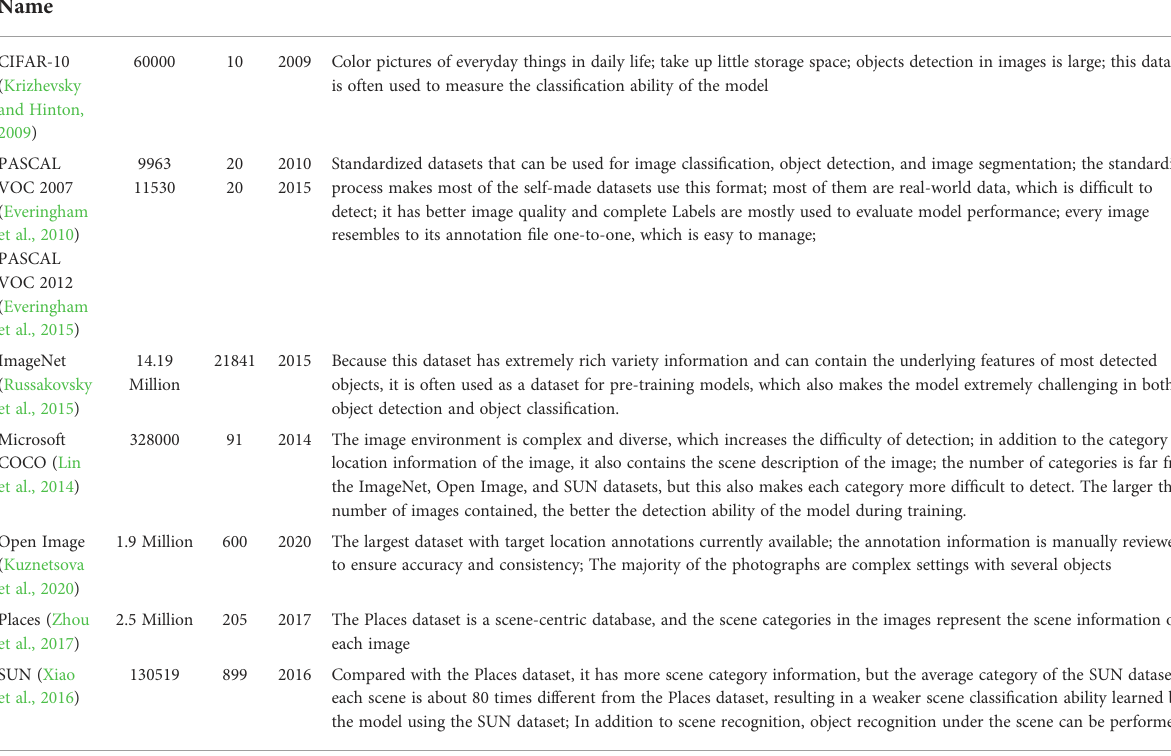
TABLE 1 Comparison of related data